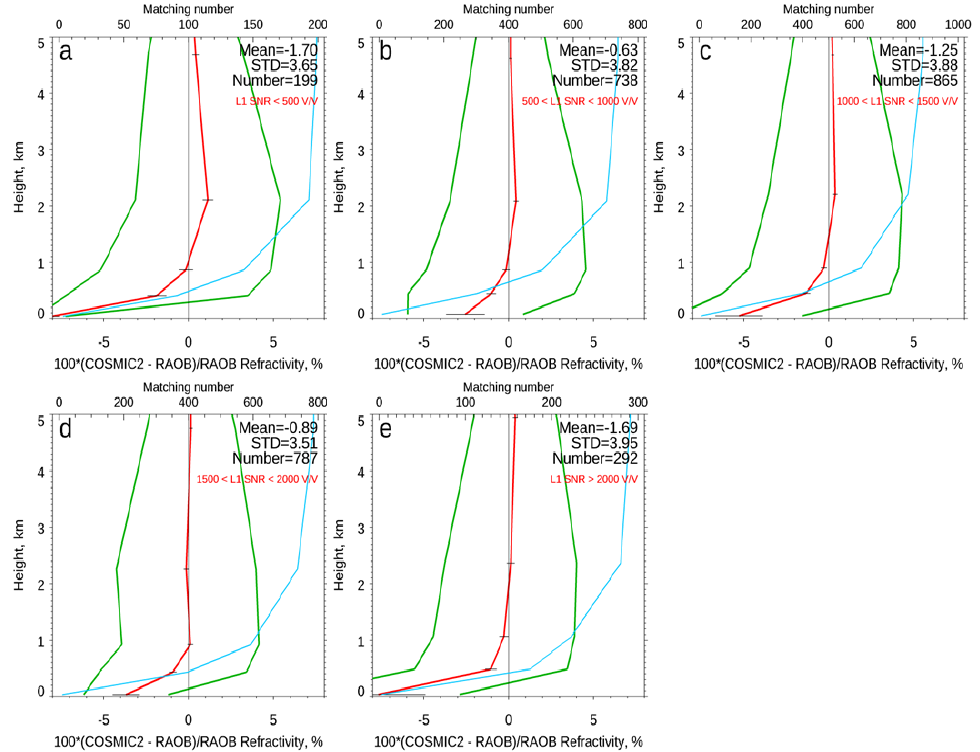
Figure 13. Similar to Figure 12 but for COSMIC-2 profiles for SNR of ( a ) 0–500 v / v group, ( b ) 500–1000 v / v group, ( c ) 1000–1500 v / v group, ( d ) 1500–2000 v / v group, and ( e ) > 2000 v / v group. The SEM is in the horizontal black lines superimposed on the mean. The sample numbers at 5 km altitude are listed in the figures. The sample numbers are in the blue line, the mean di ff erences are in the red line, and the standard deviation values are in the green line. Table 3. The mean fractional refractivity di ff erence and standard deviation from the surface to 5 km altitude for five SNR groups.